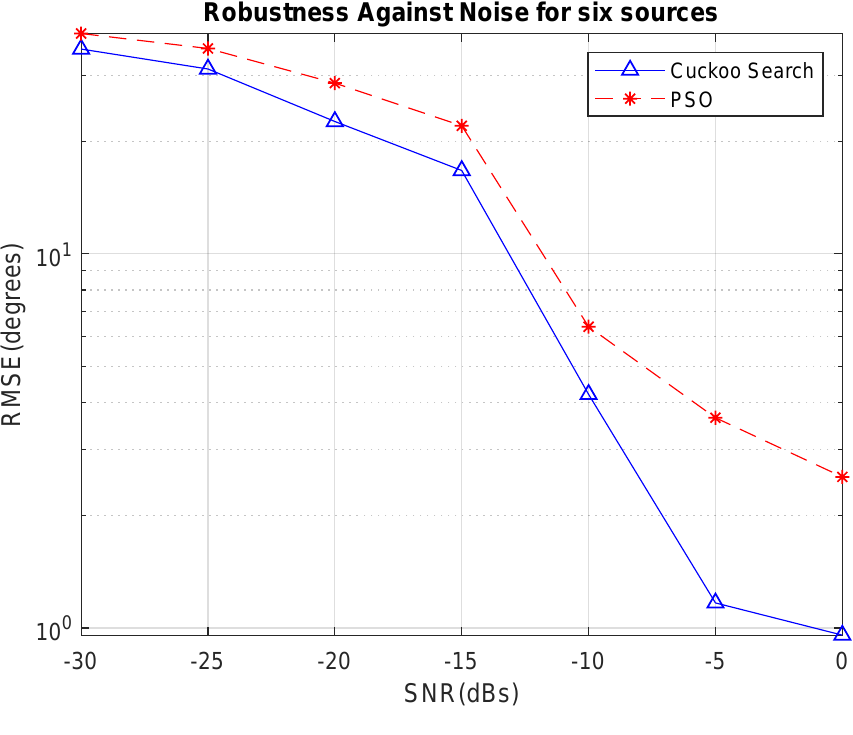
Figure 4. Estimation of robustness using six sources.